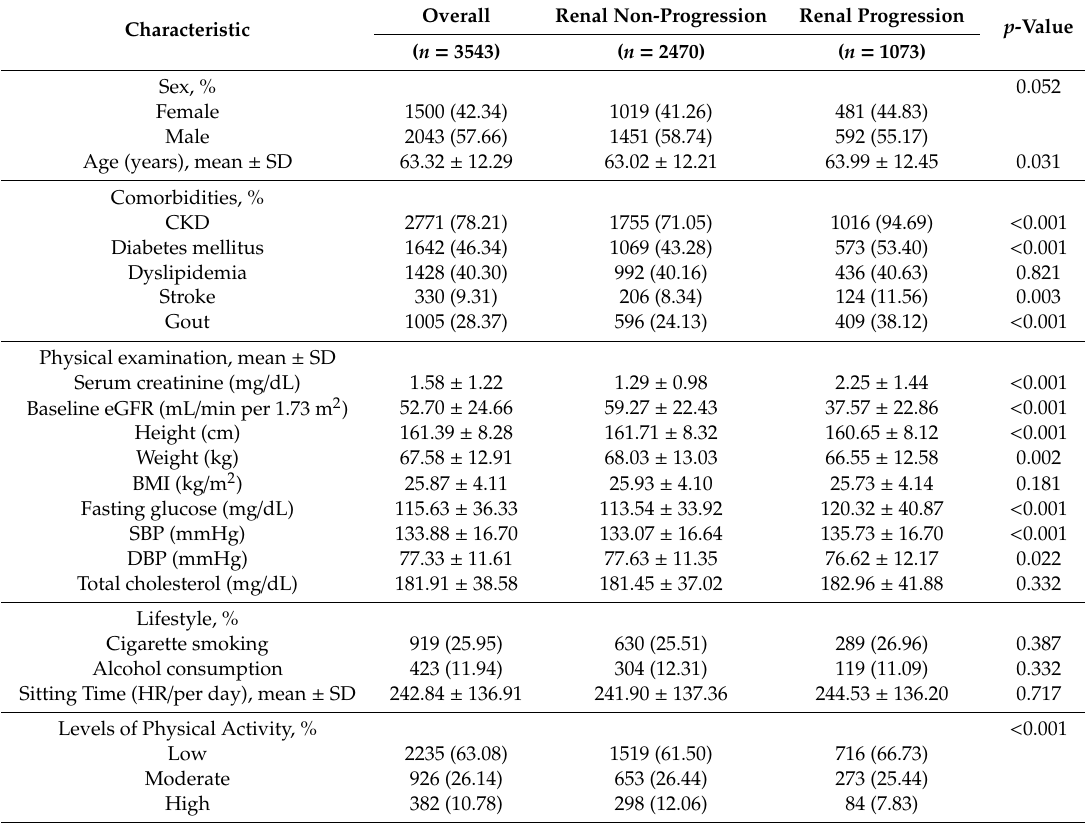
Table 1. The baseline characteristics